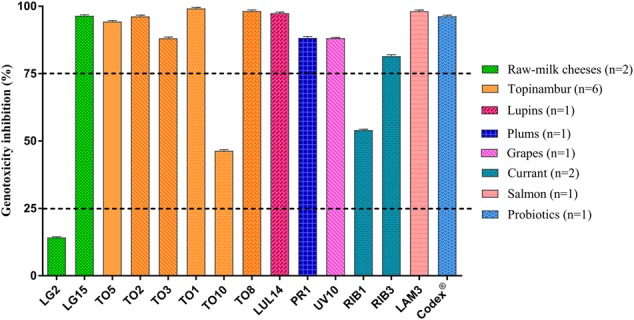
In vitro antigenotoxicity of yeasts species and strains toward 4-NQO in the SOS-Chromotest. Percent genotoxicity inhibition was calculated from residual activity (SOS induction factor) evaluated on supernatants in relation to that of a positive control. The dashed lines show the threshold levels for antigenotoxicity. Data are shown as means from three replicates. Bars indicate the standard deviation (SD). Saccharomyces boulardii Codex® was used as reference strain and different column patterns show different species (LG2, LG15 Debaryomyces hansenii; LUL14, TO8 Wickerhamomyces anomalus; UV10 Candida apicola; TO1, TO10 Pichia fermentans; RIB1, RIB3 Metschnikowia aff. fructicola; TO2, TO3 Torulaspora delbrueckii; PR1 Meyerozyma guilliermondii; TO5 Hanseniaspora uvarum; LAM3 M. raukafii).